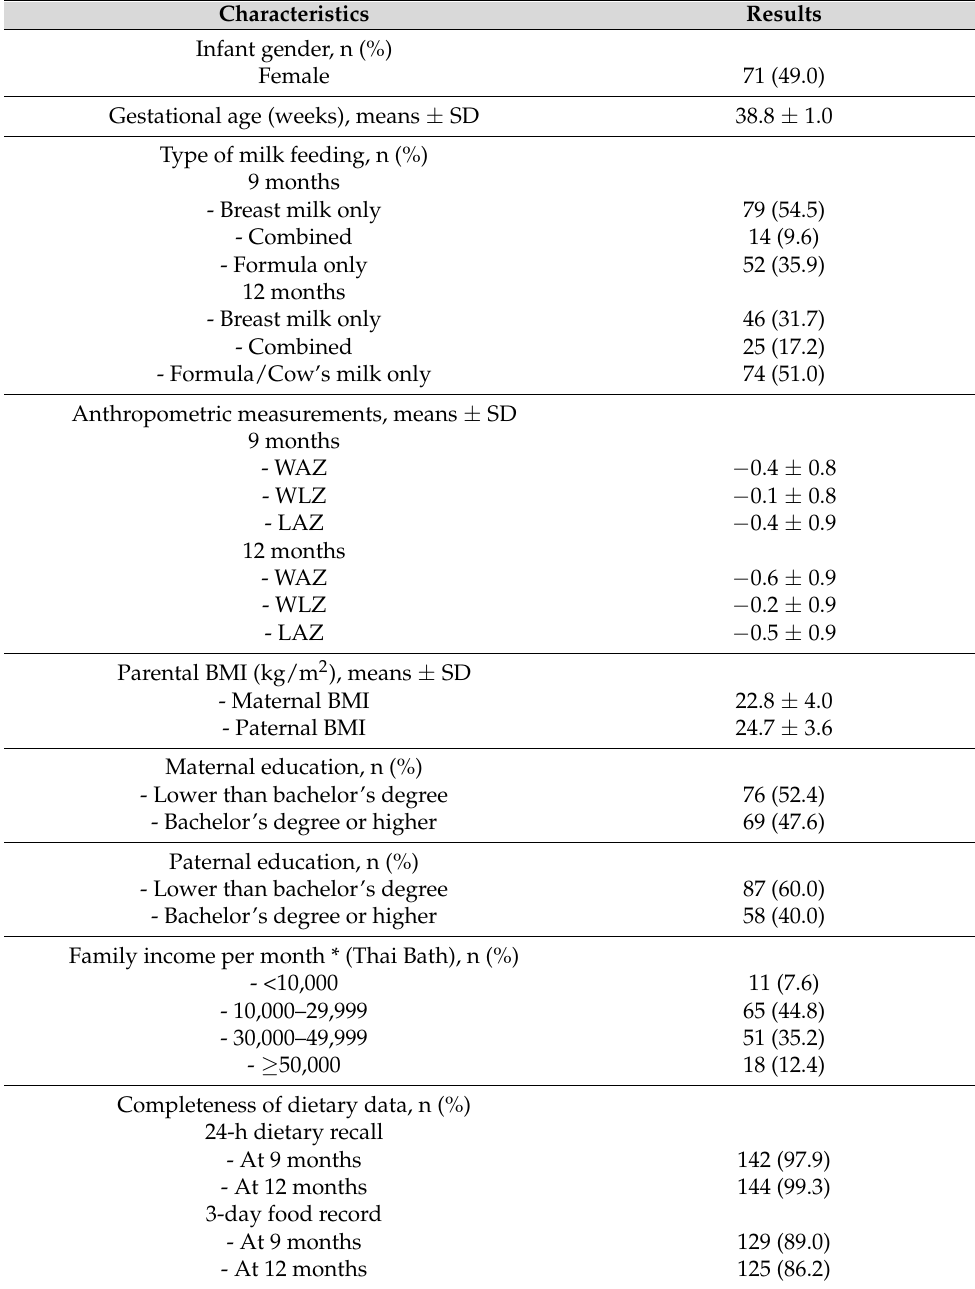
Table 1. Characteristics of participants ( n =